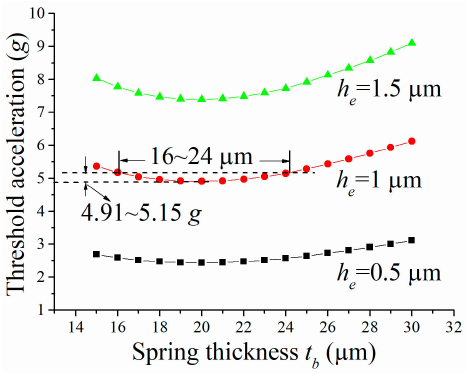
Figure 2. Threshold acceleration changes with the spring thickness in cases of different electrode-gap heights.